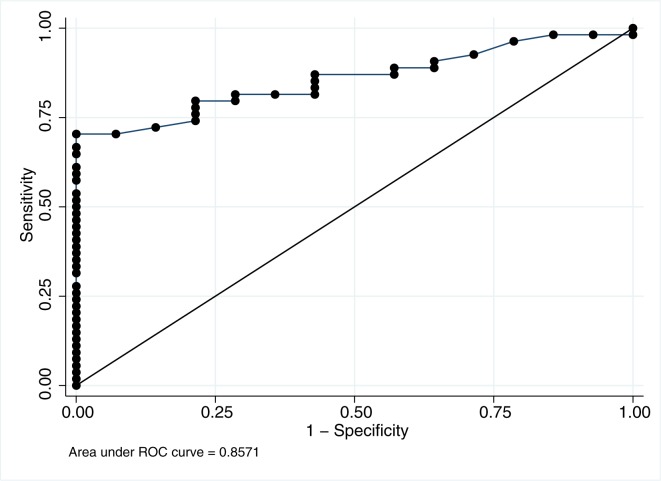
sMR as a predictor of portal hypertension.Receiver operating characteristic (ROC) analysis of sMR as a predictor for CSPH in patients with alcoholic cirrhosis.